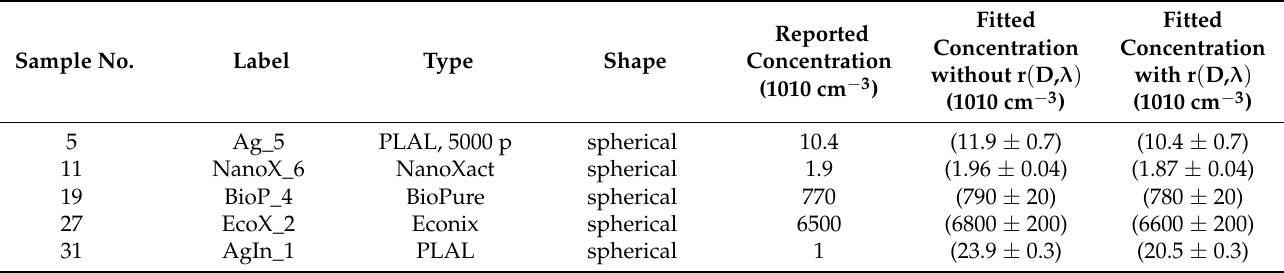
Table 3. Labels, types, shapes, reported and fitted concentrations for representative colloidal solutions of silver nanoparticles with corresponding error.